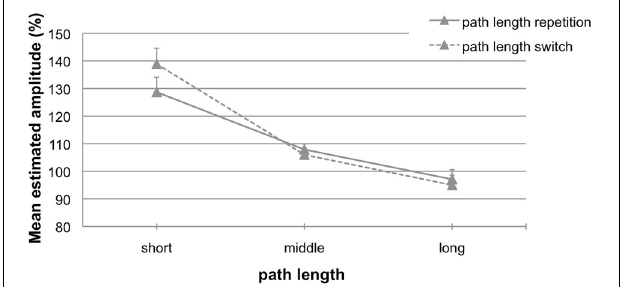
FIGURE 6 | Mean estimated amplitude (%) for trials with path length repetitions (solid line) and path length switches (dashed line) in the condition perturbed hand motions . A performance of 100% indicates exact replications. Error bars represent the standard error of the